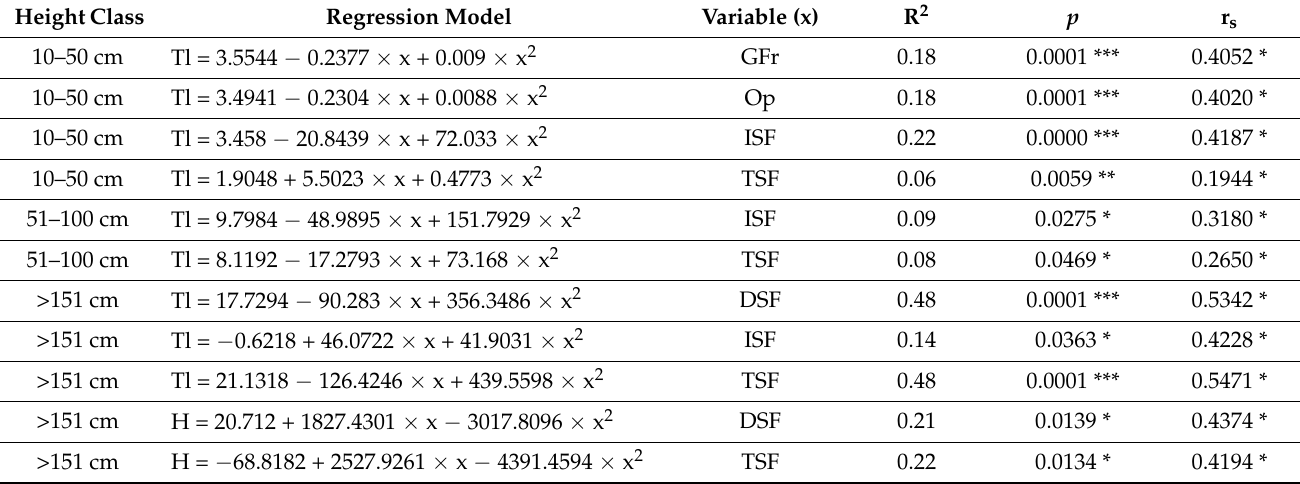
Table A2. Significantly proved regression models of light intensities and morphological parameters expressing height growth of Norway spruce natural regeneration under size-dependent evaluation.